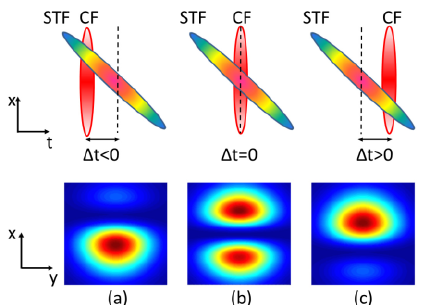
Figure 4. Upper panel: Schematic illustration of the concept of interferometric characterization of PFT of SSTF pulses. Lower panel: The simulated interference patterns at the different time delays in the experiment. STF: femtosecond laser pulse with spatiotemporal focusing; CF: femtosecond laser pulse with conventional focusing; Δ t : time delay between STF and CF. ( a ) Δ t < 0; ( b ) Δ t = 0; ( c ) Δ t > 0. Reproduced with permission from [30], Copyright The Optical Society, 2014.